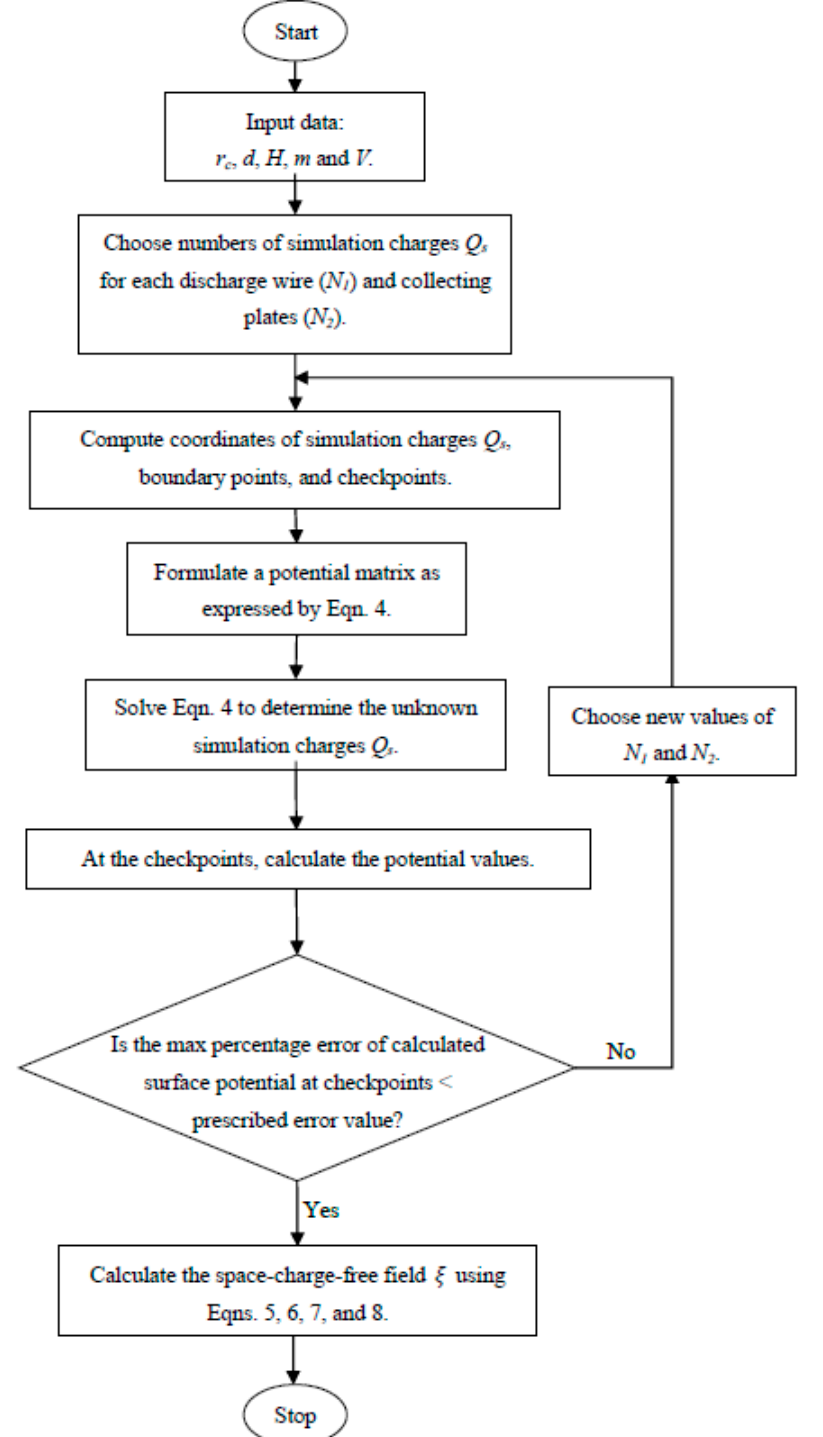
Figure 3. Flowchart for calculating the space-charge-free field in ESP.